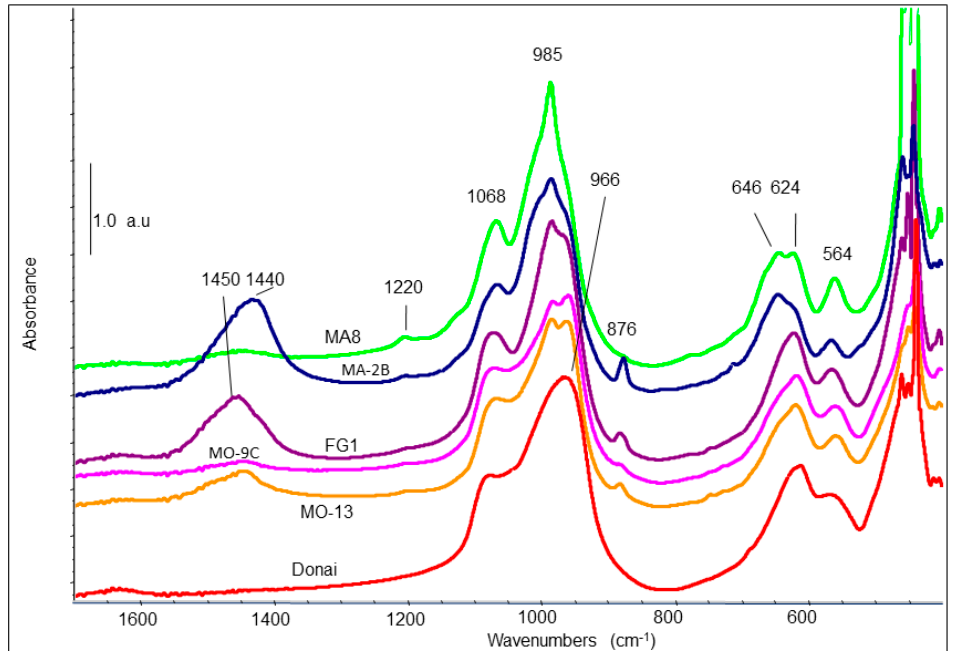
Figure 7. FT-IR spectra of the serpentinites in the 1700–400 cm − 1 range.